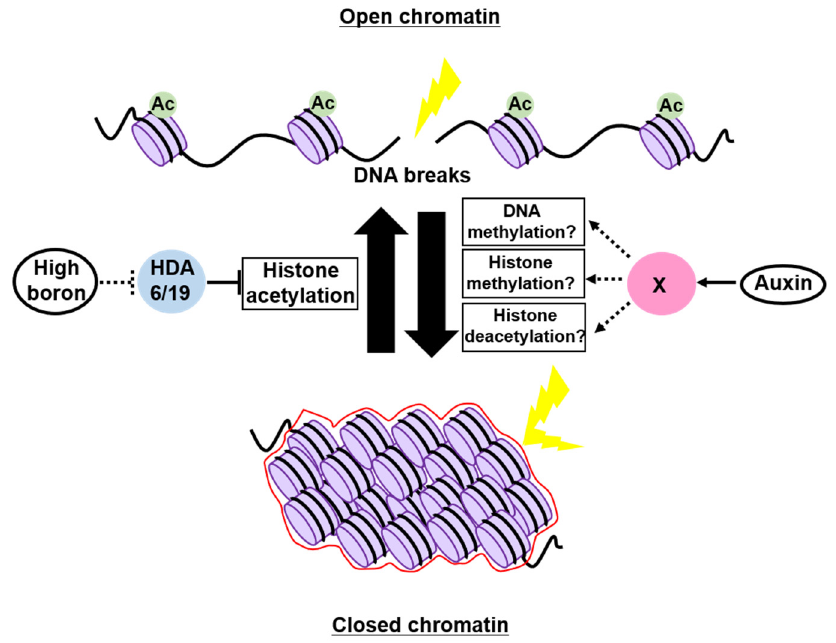
Figure 3. Epigenetic regulation of the chromatin structure involved in genome maintenance in plants. Excess boron opens up chromatin by enhancing histone acetylation, which may require the inhibition of HDACs, HDA6, and HDA19, thereby increasing the susceptibility to DNA damage. On the other hand, auxin promotes chromatin condensation and provides tolerance to genotoxic stress. The chromatin modifier(s) that function downstream of auxin signaling remain unknown.